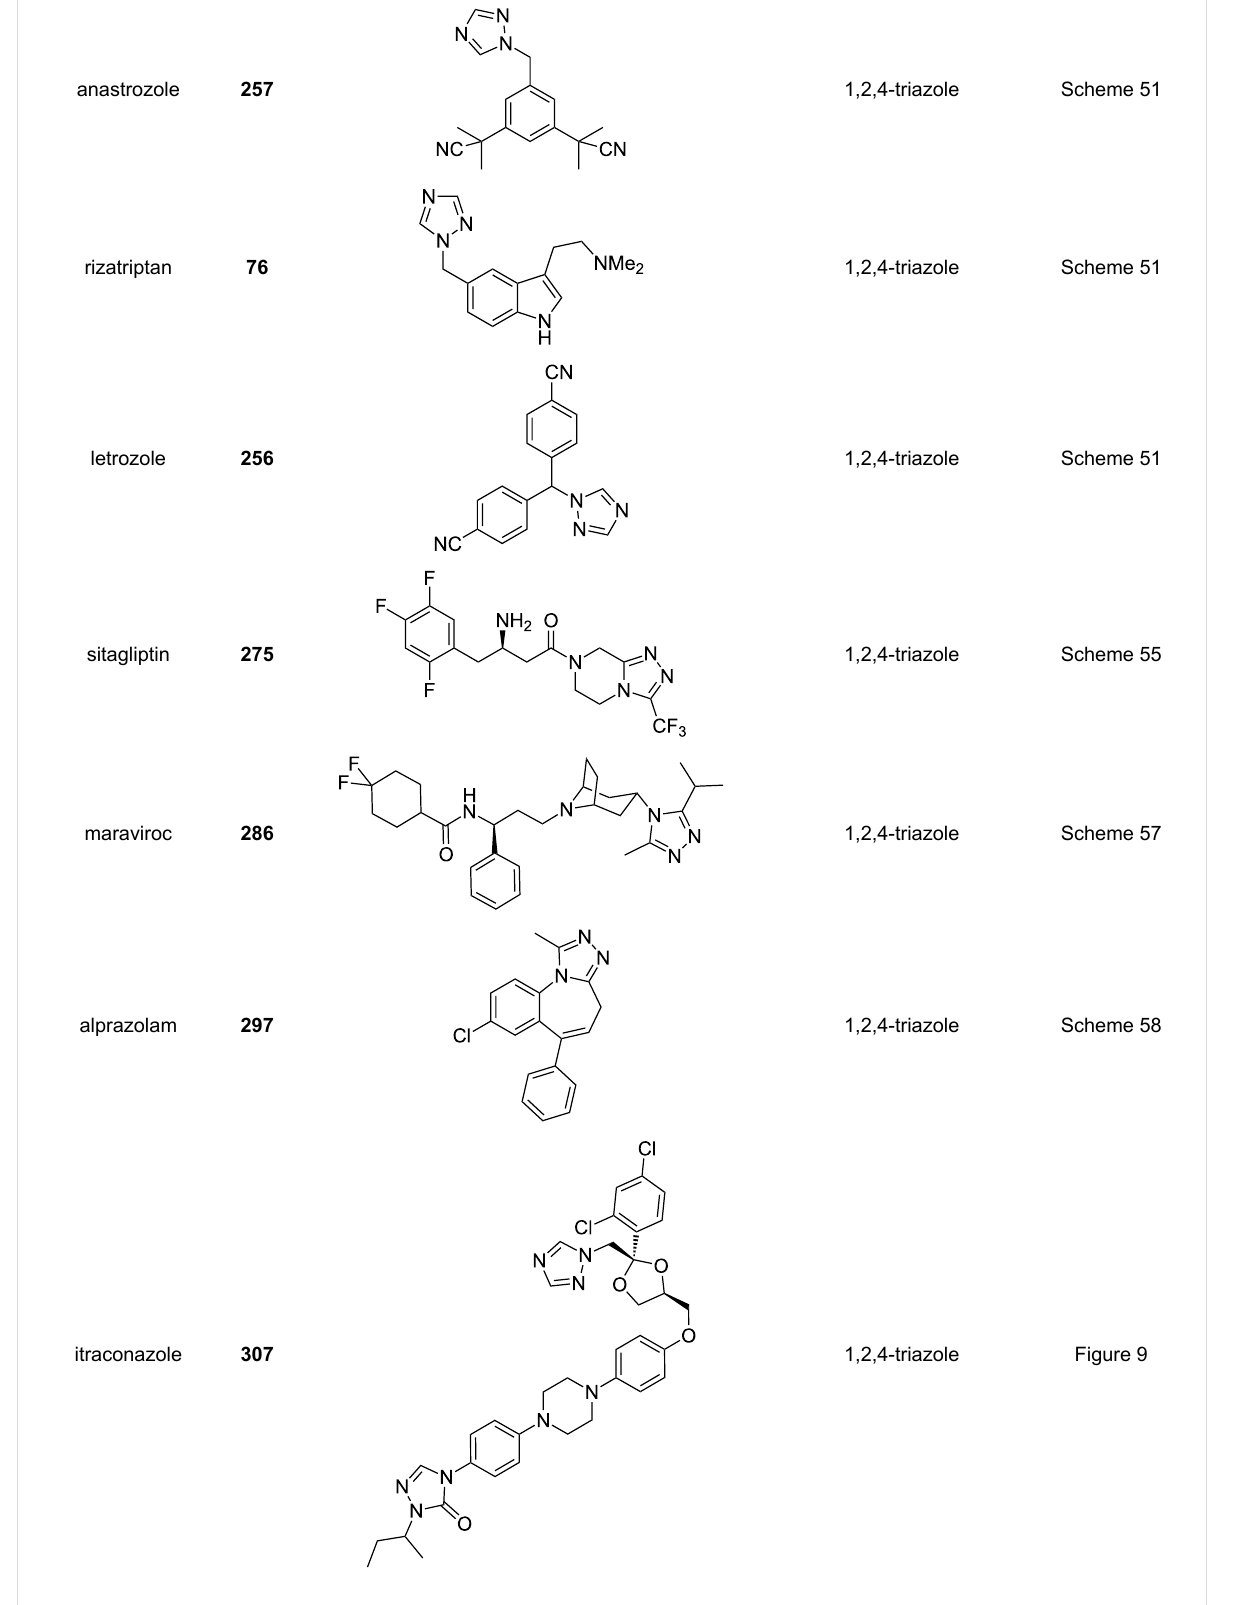
Table 1: Heterocylic structures discussed in this review. (continued)